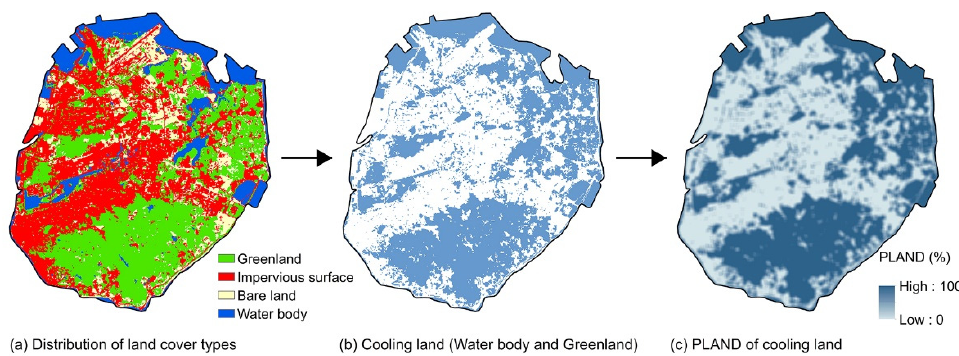
Figure A2. The consistency between the original landscape and land coverage results calculated with PLAND.